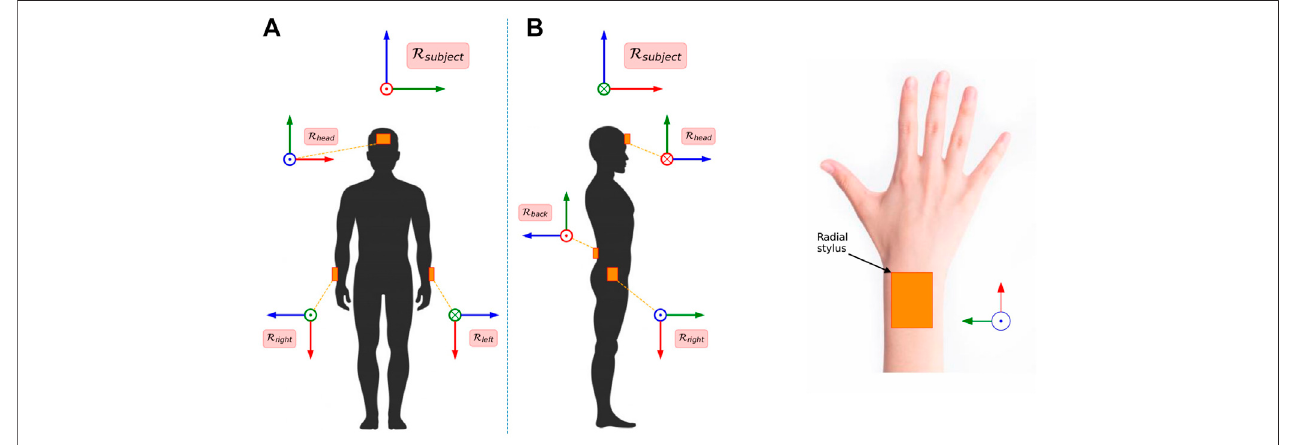
FIGURE 1 | Sensor position on the upper body (A) and sensor position on the right wrist (B) . Colors red, green and blue correspond to axes X, Y, and Z of the sensors, respectively. The data from the forehead sensor and the back sensor were not included in the present